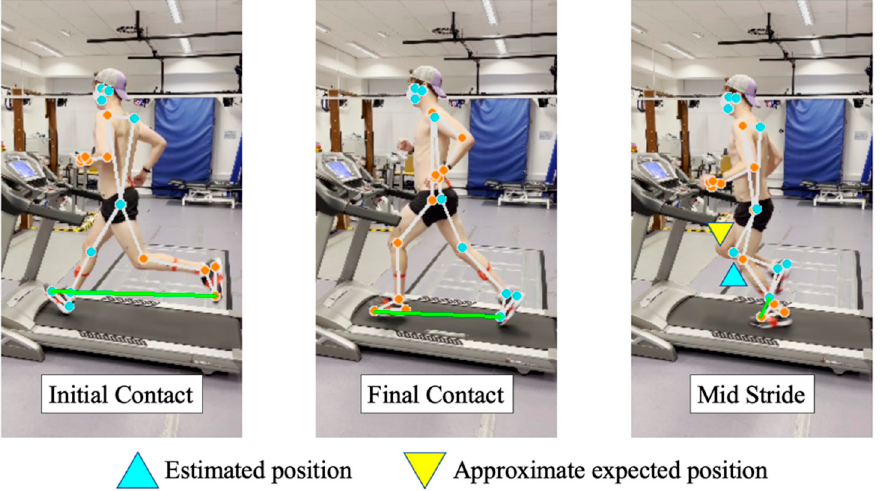
Figure 8. An example of pose estimation output at three different stages of the gait cycle, (i) initial contact, (ii) final contact, and (iii) mid-stride. As shown, during non-occluded segments of the gait cycle (IC/FC), estimated anatomical locations closely resemble their expected positions. However, observing mid-stride (during occlusion between left/right legs) one can begin to see the estimated anatomical locations deviate from expected positions on the right leg (e.g., knee), providing insight behind lower accuracy experienced by right leg gait outcomes.